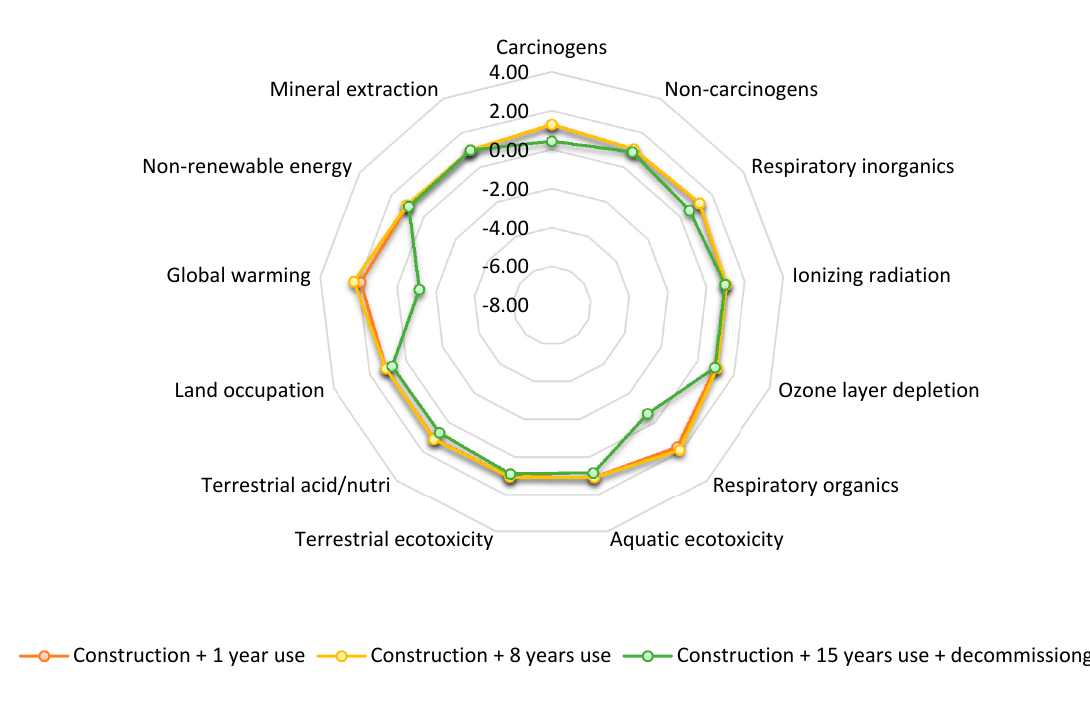
Figure 3. Relative impact assessment for the heat pump with varying use duration. The different factors are made dimensionless by dividing each value by the average value of the factors.